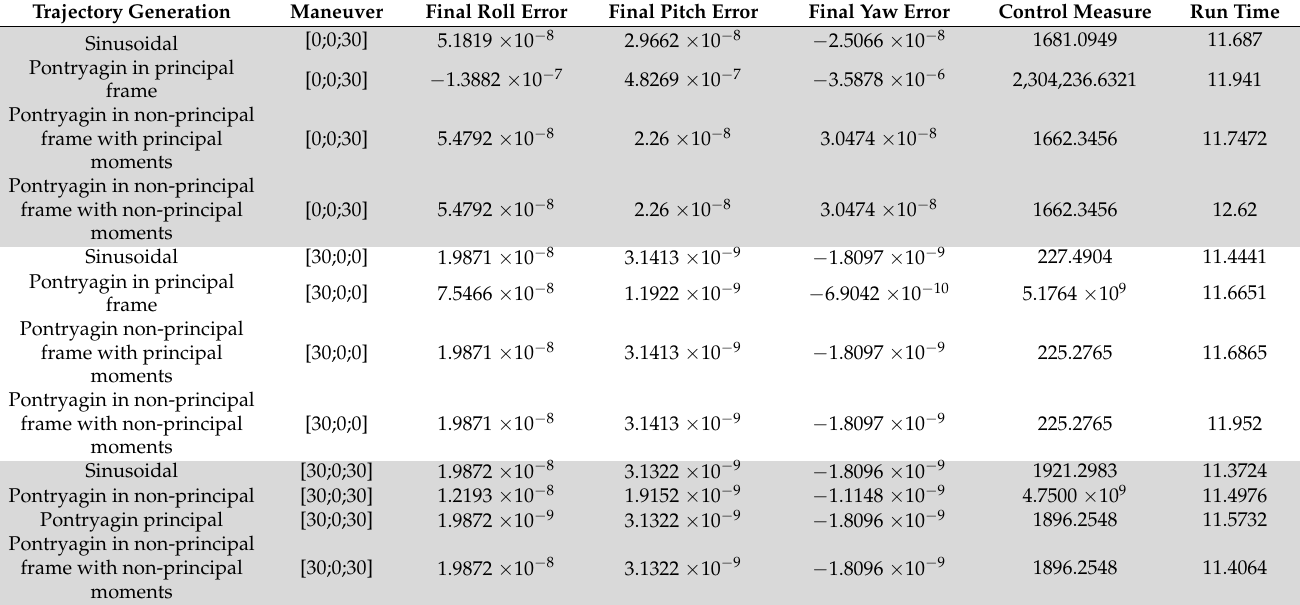
Table 6. Comparison of various methods of cross-coupling elimination in Pontryagin trajectory generation versus sinusoidal trajectory generation for different maneuvers.